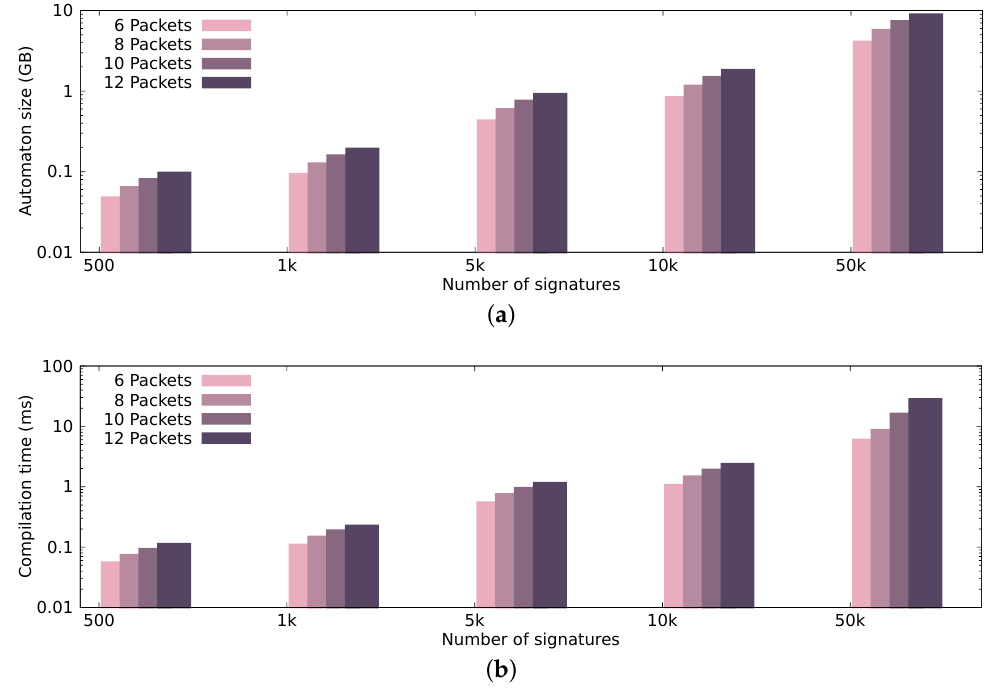
Figure 7. Automaton size and compilation time using different combinations of patterns and pattern sizes. ( a ) Automaton size; ( b ) Automaton compilation